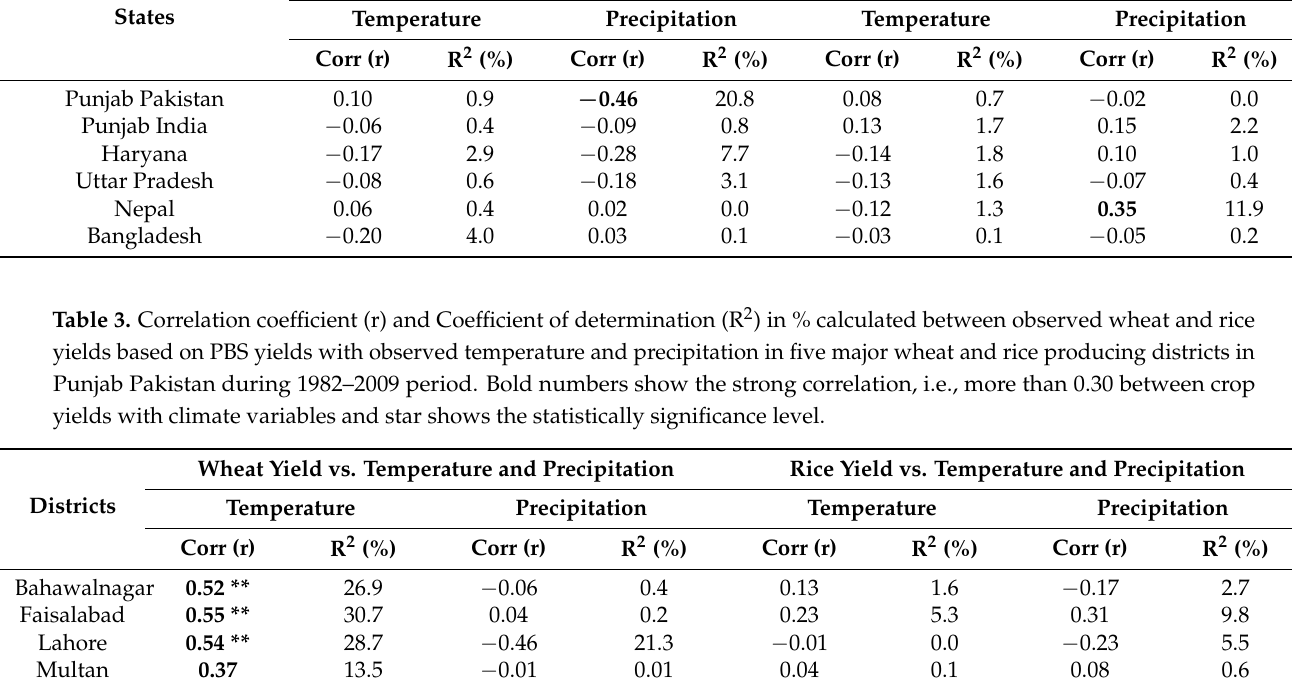
Table 2. Correlation coefficient (r) and Coefficient of determination (R 2 ) in % calculated between detrended observed wheat and rice yields based on FAO statistics with statistically downscaled temperature and precipitation over six study sites in the IGB river basin during 1981–2010 period. Bold numbers show the strong correlation, i.e., more than 0.30 between crop yields with climate variables. Wheat Yield vs. Temperature and Precipitation Rice Yield vs. Temperature and Precipitation States Temperature Precipitation Temperature